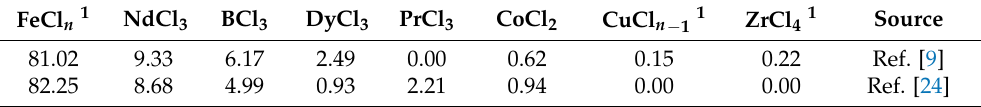
Table 1. Different feed compositions in mole% of complete chlorinated NdFeB magnets.